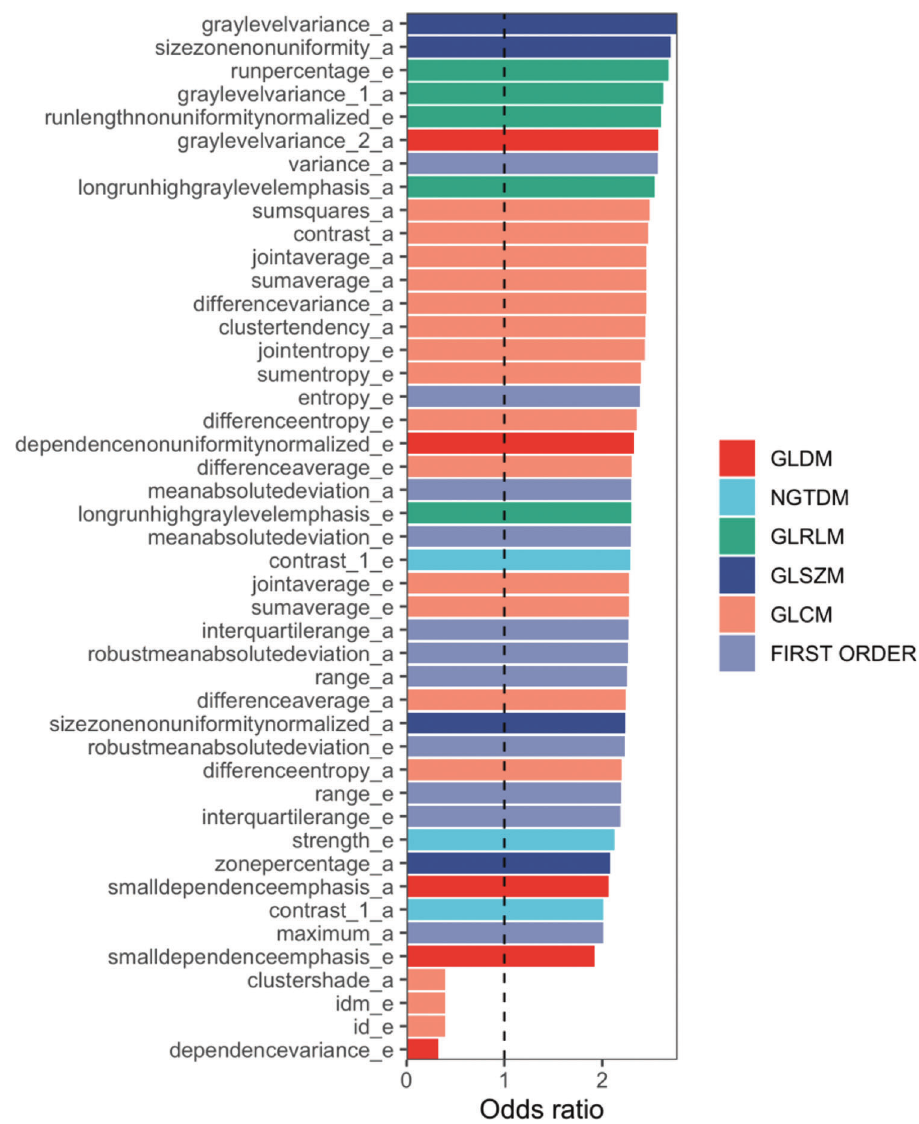
Figure 4 - Features significantly ( p o 0.05) related to treatment response. When odds ratio 4 1, the higher their values the higher the chance for sustained response, whereas when odds ratio o 1 the higher the values the lower the chance for sustained response. a (arterial phase), e (equilibrium phase). GLCM (Gray Level Co-occurrence Matrix), GLSZM (Gray Level Size Zone Matrix), GLRLM (Gray Level Run Length Matrix), NGTDM (Neighboring Gray Tone Difference Matrix), and GLDM (Gray Level Dependence Matrix) are second order textural